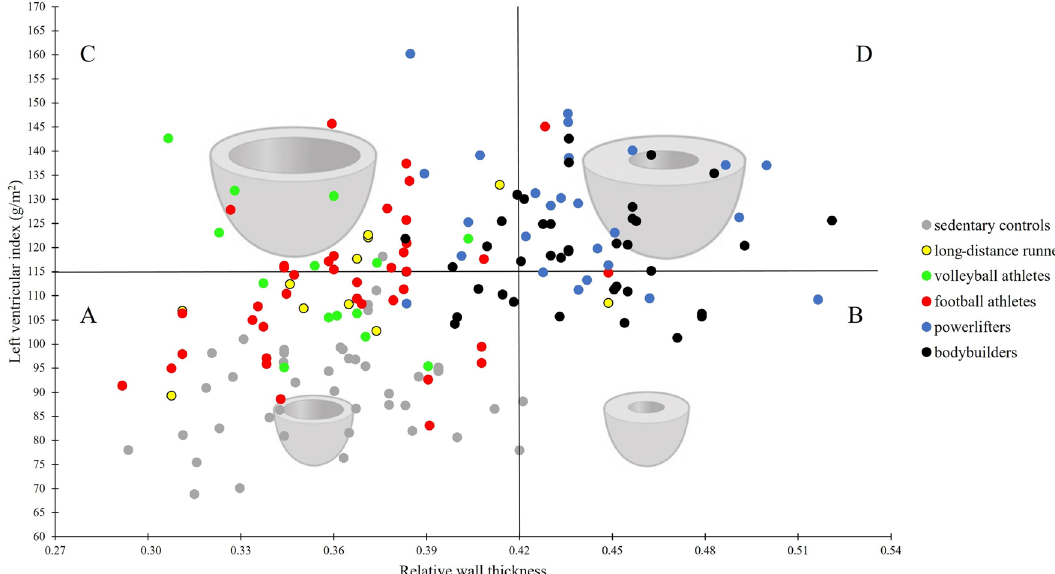
Figure 1. Left ventricular geometric patterns in long-distance runners (n = 43), volleyball athletes (n = 14), football athletes (n = 39), powerlifters (n = 26), and bodybuilders (n = 39) and sedentary controls (n = 43). ( A ) Normal pattern (RWT < 0.42 and LV index < 115 g/m 2 ); ( B ) concentric remodeling (RWT > 0.42 and LV index < 115 g/m 2 ); ( C ) eccentric hypertrophy (RWT < 0.42 and LV index > 115 g/m 2 ); ( D ) concentric hypertrophy (RWT > 0.42 and LV index > 115 g/m 2